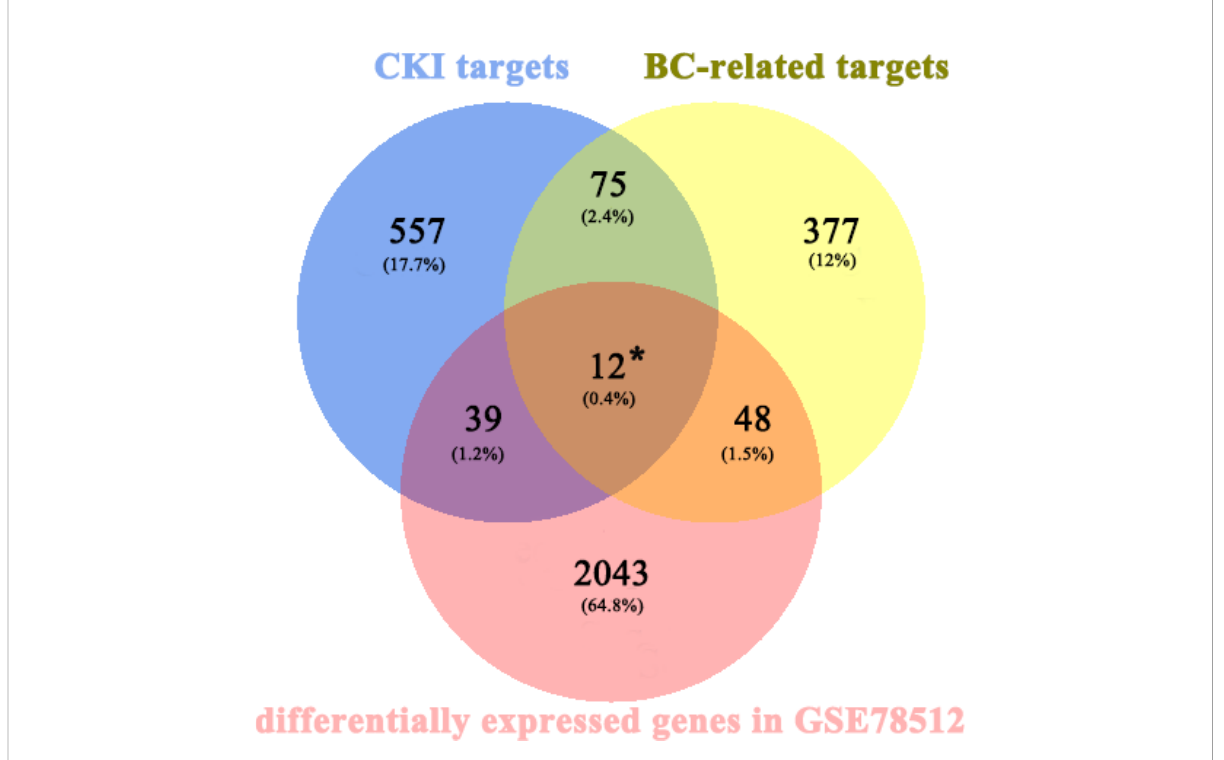
FIGURE 3 Venn diagram for CKI prediction of target genes and disease-related genes. * represent the potential anti-BC targets of